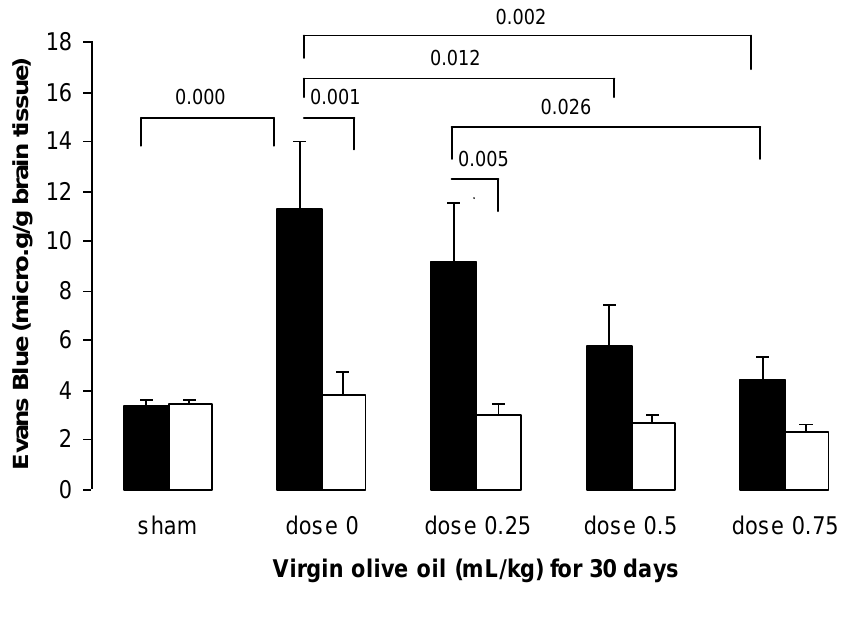
FIGURE 5. EB extravasations in various experimental groups including left and right hemisphere of sham-operated, 0, 0.25, 0.5, and 0.75 mL/kg of VOO (n =